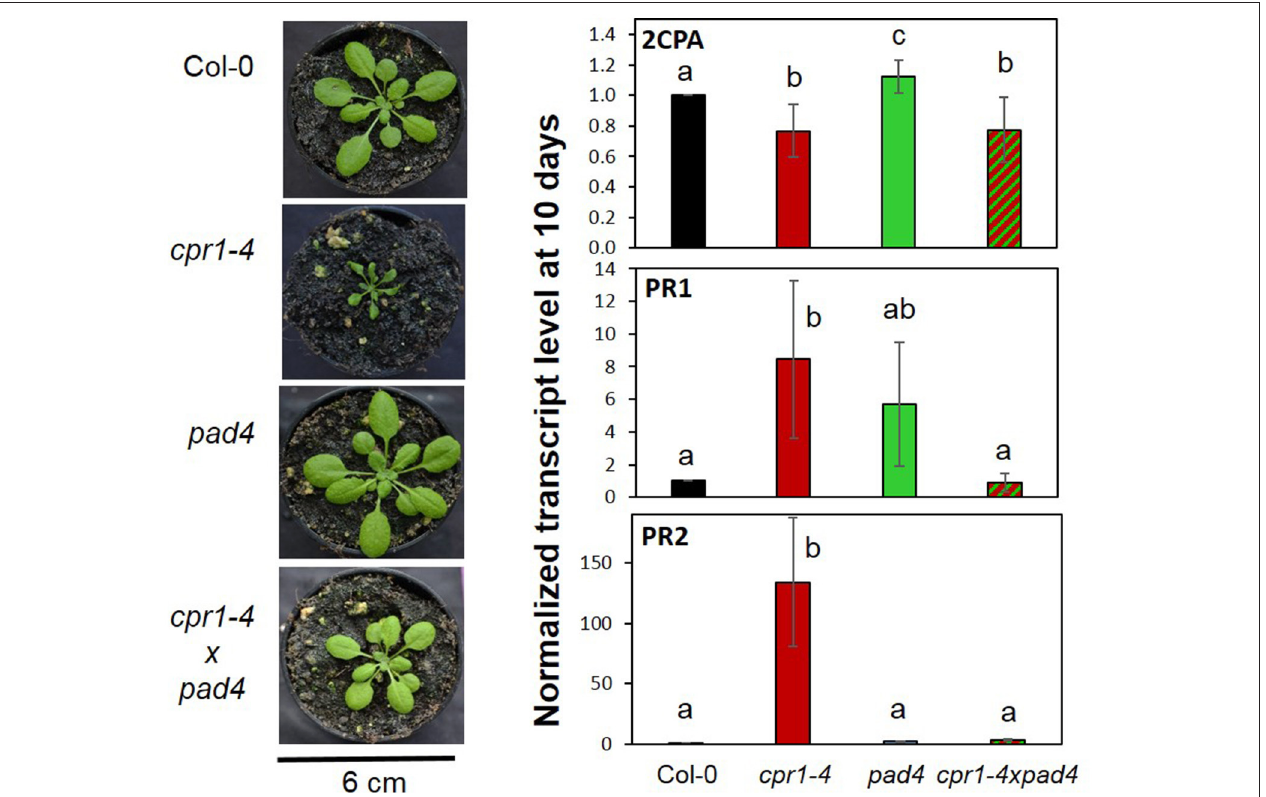
FIGURE 11 | Effect of PAD4-mediated SA induction on the habitus and gene expression regulation of cpr1-4 . cpr1-4 was crossed with pad4 . cpr1-4xpad4 double mutants were selected from the F 2 population. (Left) Habitus of 28-day-old cpr1-4 , pad4 , and cpr1-4xpad4 mutants compared to Col-0 wildtype plants. (Right) 2CPA , PR1 , and PR2 transcript levels in 10-day-old Col-0, cpr1-4 , pad4 , and cpr1-4xpad4 plants grown aseptically on MS-medium. The means were calculated from 3 technical replicates per probe and 1–3 probes per 3 independently grown plant sets. For each probe, RNA was extracted from 50 seedlings. Statistically different results are indicated for each gene with different letters (ANOVA, p <